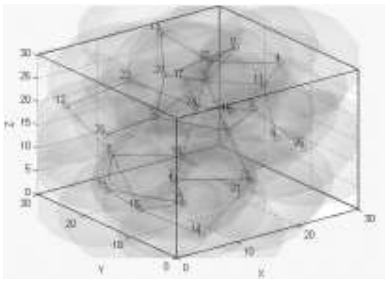
Figure 6. Final distribution of AUVs (bounded node degree).